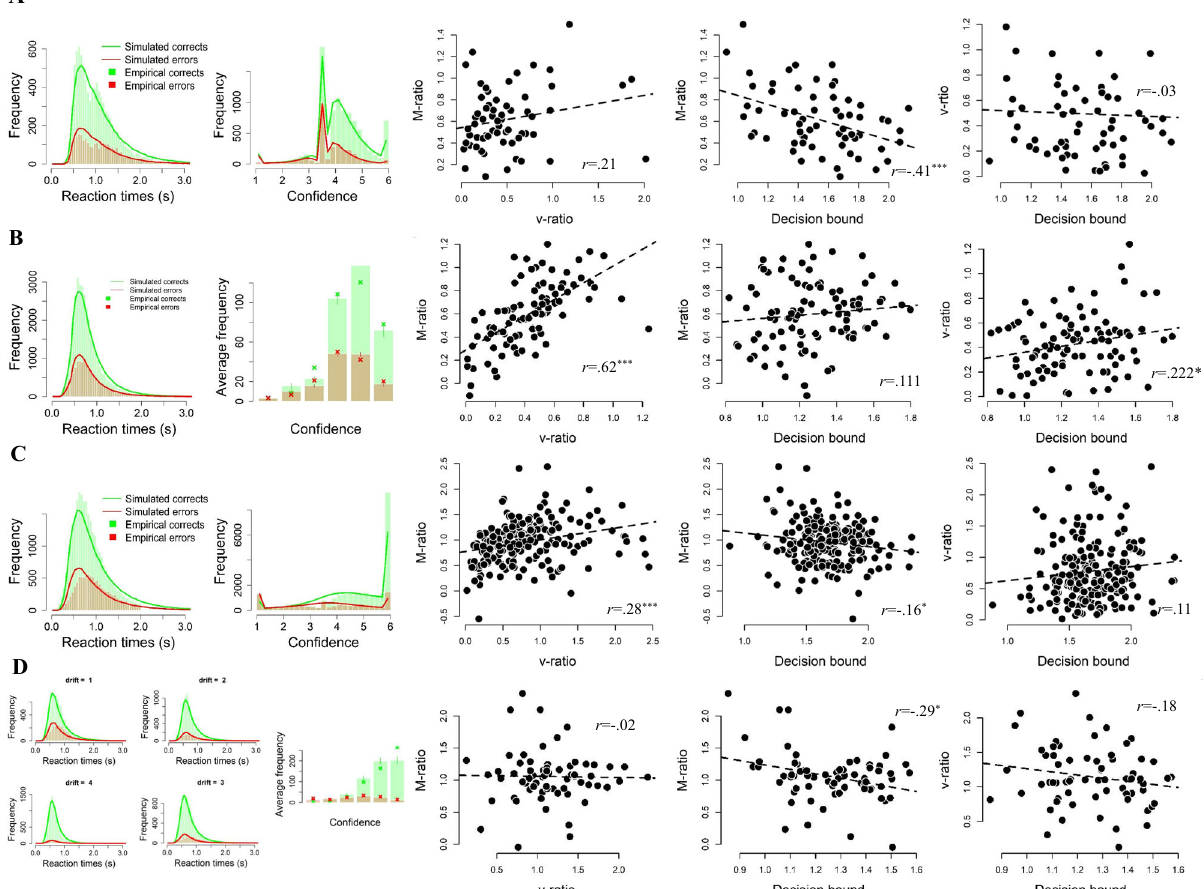
Fig. 4 The in fl uence of spontaneous variations in speed-accuracy tradeoff on metacognitive accuracy, separated by experiment. Results are shown seperately for Experiment 2 A (panel A; N = 63), 2B (panel B; N = 96), 2 C (panel C; N = 204) and 2D (panel D; N = 67). Same convention as in Fig. 2; error bars re fl ect SEM. Source data areprovided as a Source Data fi